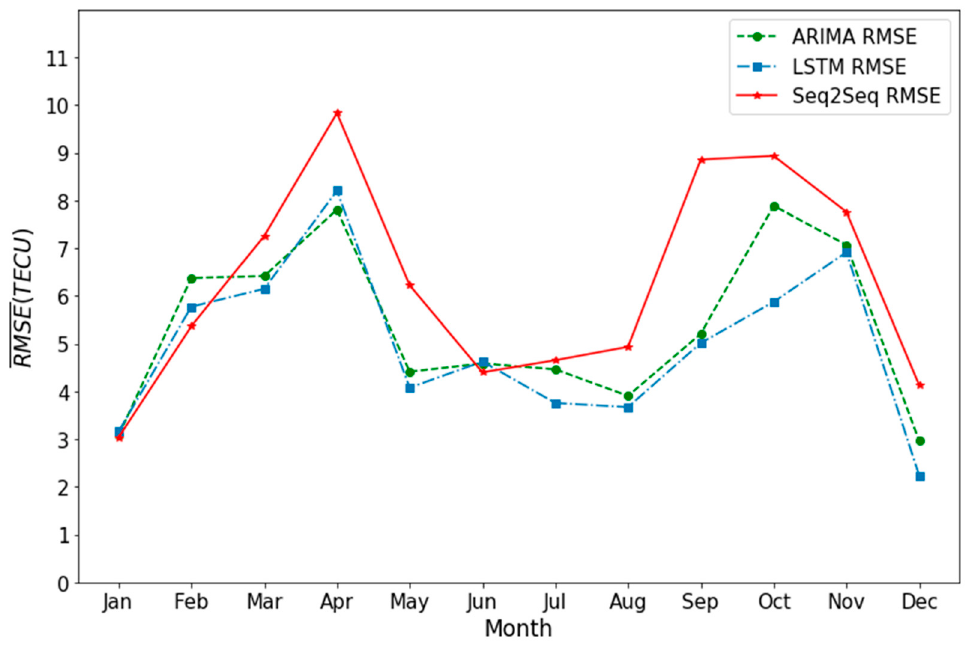
Figure 8. The variation of the averaged RMSE in different months by three algorithms (green: ARIMA; blue: LSTM; red: Seq2Seq).